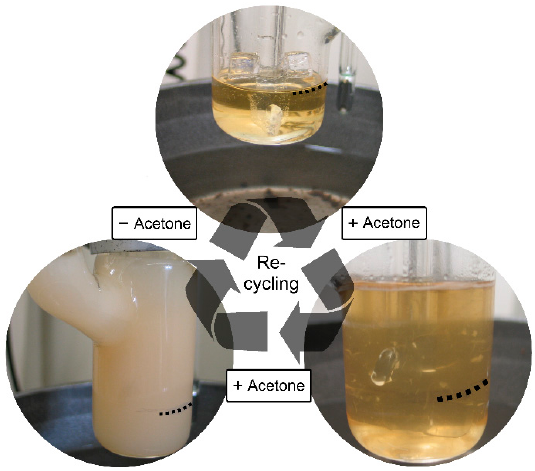
Figure 11. Recycling scheme of a regeneration-dissolution cycle of cellulose in QAE/acetone by simple addition or removal of acetone; reprinted with permission from [195], Copyright (2015) GIT Labor-Fachzeitschrift, Wiley-VCH Verlag. Table 3. Zero shear viscosities ( η 0 ) of cellulose solutions (2.4 wt %), 20 ◦ C [193]. 2.4 wt % Cellulose Dissolved